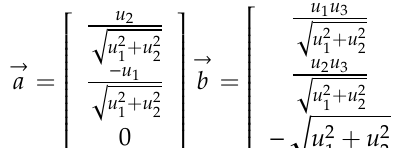
Figure 6. ( a ) The schematic of the unit vector. ( b ) The schematic of the normal plane and 𝑎⃗ , 𝑏(cid:4652)(cid:4652)⃗ . ( c ) Carbon paper structure obtained by this stochastic reconstruction method.